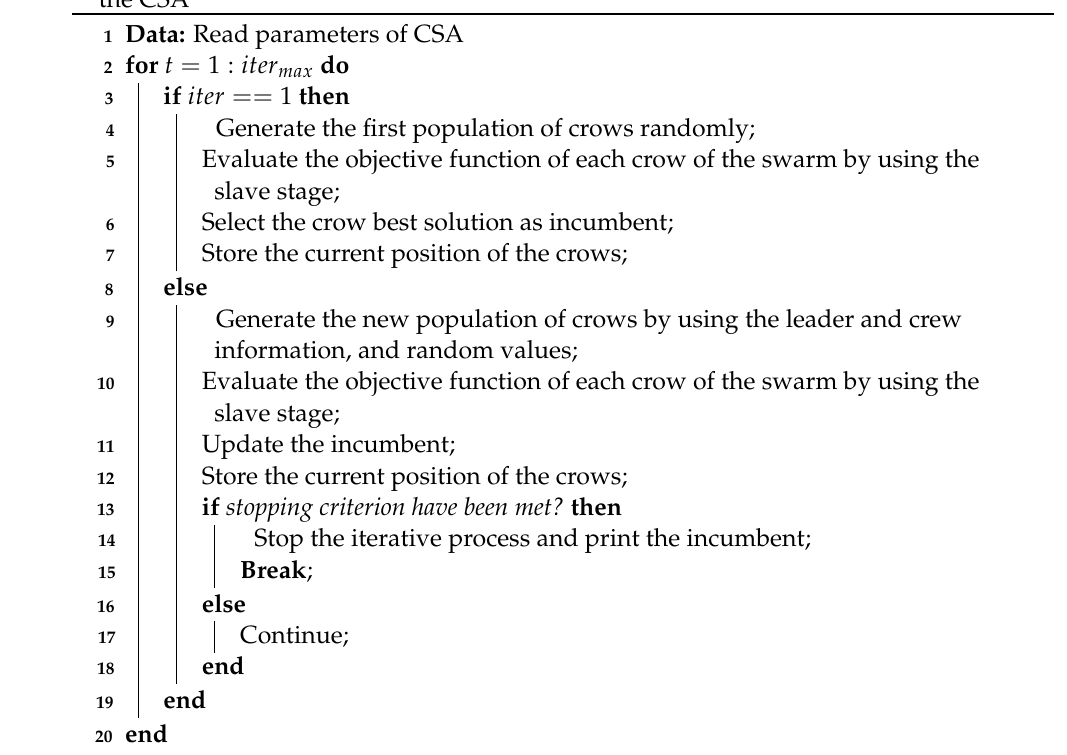
Algorithm 3 Algorithm proposed for the master–slave methodology based on the